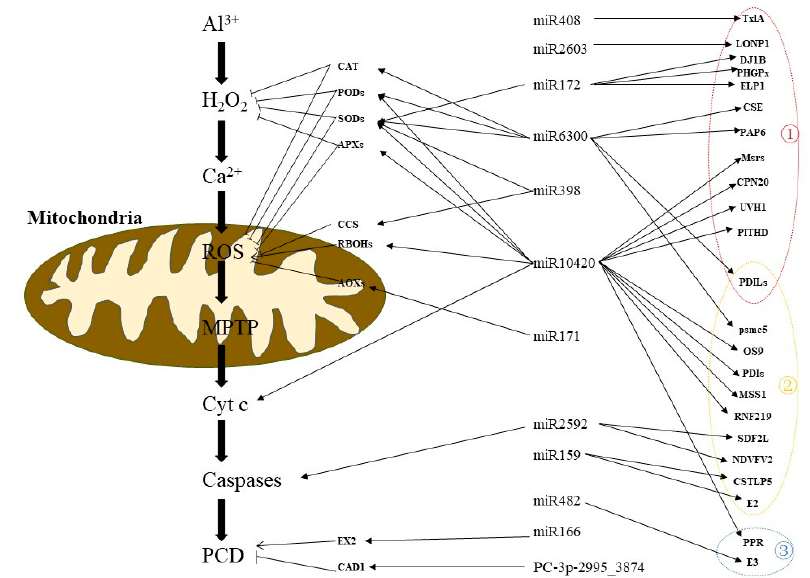
Figure 9. Proposed working model for PCD induced by Al. The sharp head represents promotion, whereas the flat head represents suppression. ROS: Reactive oxygen species; MPTP: Mitochondrial permeability transition pore; Cyt c: Cytochrome C; Caspases: Cysteinyl aspartate specific protein- ase; PCD: Programmed cell death; numbers enclosed in circles in the figure represent: ① , oxidative stress; ② , endoplasmic reticulum stress; ③ , programmed cell death regulation. For detailed expla- nation, see Table S7 and Figure 6.